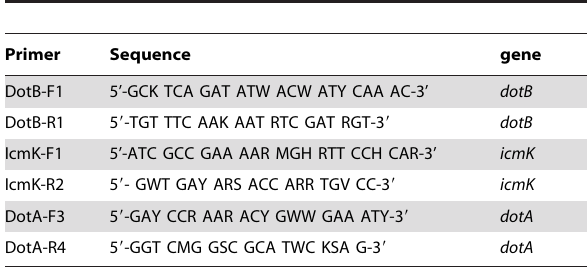
Table 1. Degenerate primers used for the initial amplification of P. salmonis dotB , dotA and icmK